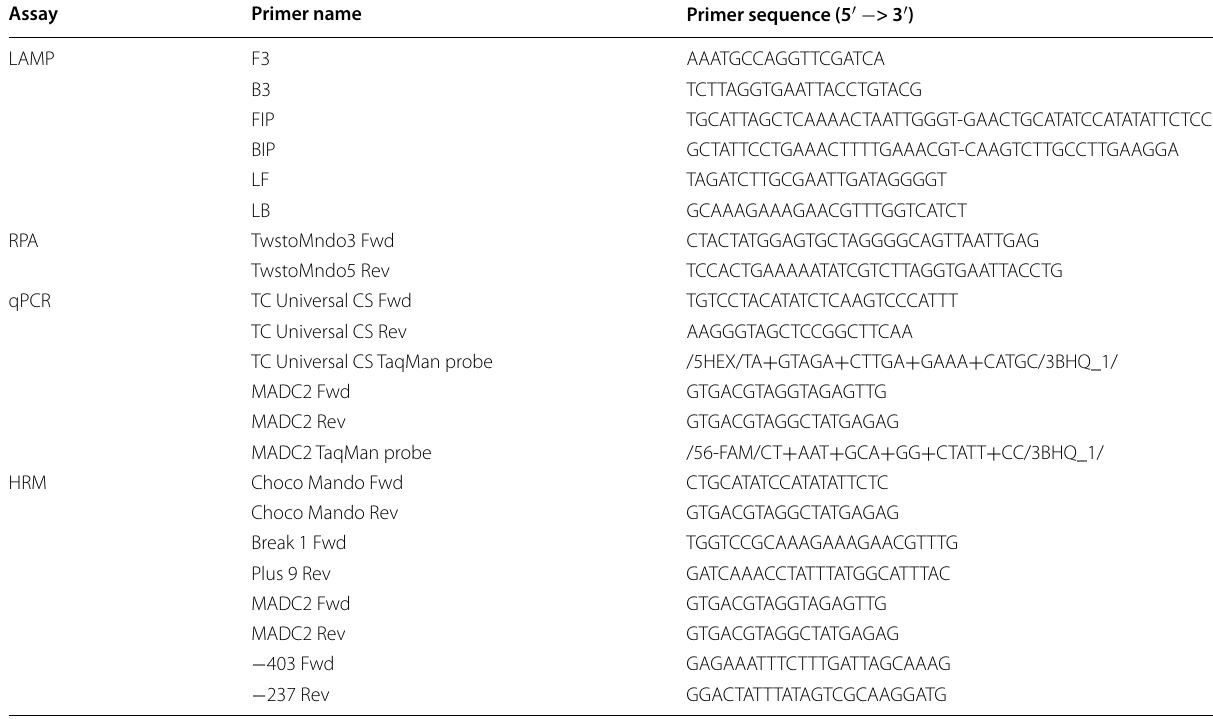
Table 1 Table of primers: primers used in the pre-amplification, LAMP, RPA, qPCR, and HRM reactions. Primer’s sequences for male detection. The following primers are from 9 and 15: MADC2 Fwd and MADC2 Rev. The other primers listed are novel designs that target the same amplicon region or a nearby loci to gain the same discrimination between males and non-males. The first column designates the type of end-point assay to be used that include loop-mediated isothermal amplification (LAMP), recombinase polymerase amplification (RPA), quantitative polymerase chain reaction (qPCR), and high-resolution melting (HRM). All sequences are provided in a 5 ′ to 3 ′